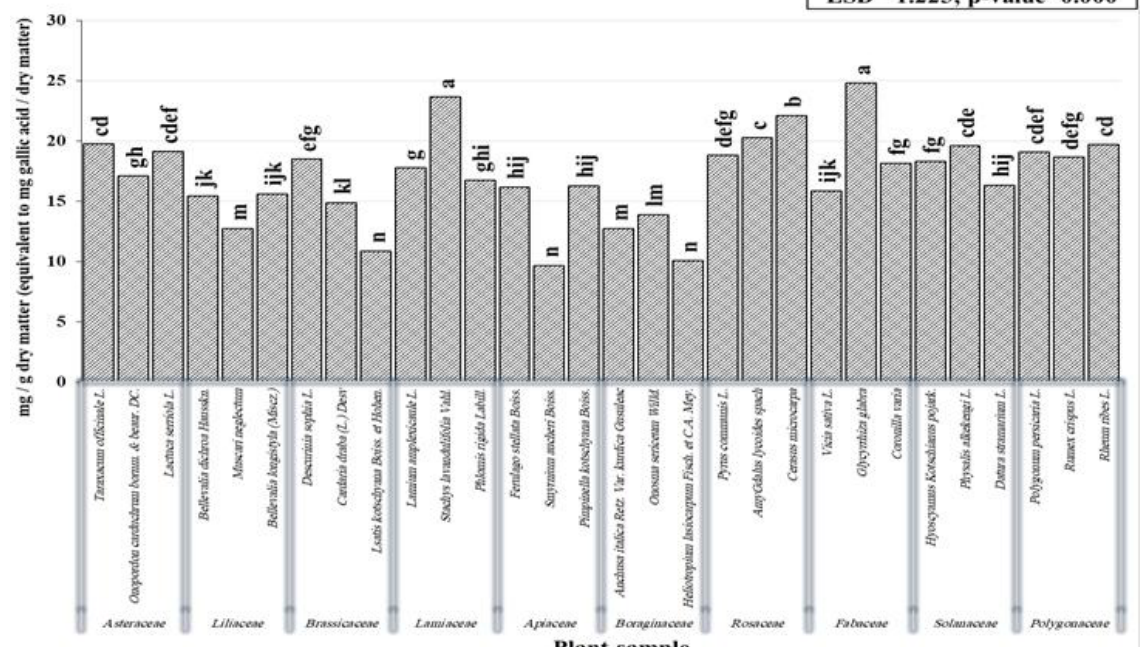
Fig. 10. Comparison of the average of phenolic compounds in the studied plant species under the influence of the plant